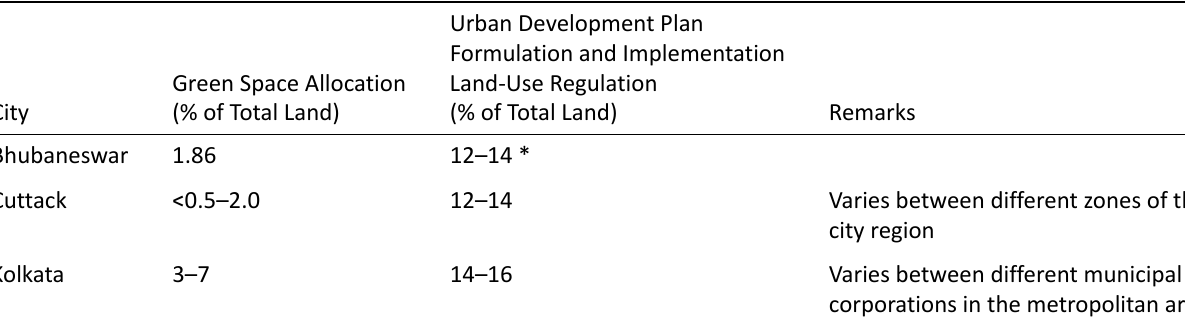
Table 1. Provision of organized green space in the selected cities.